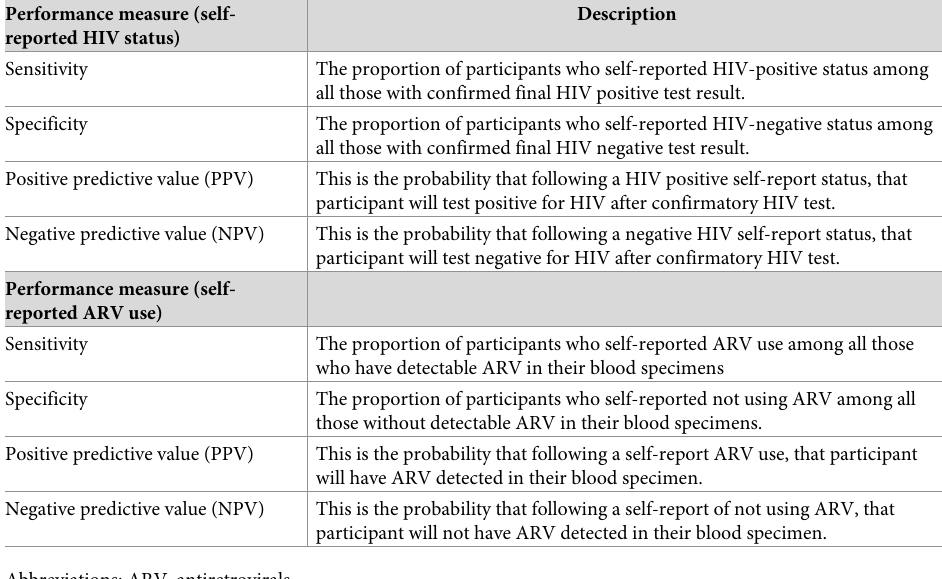
Table 1. Description of measures used in assessing performance of self-reported HIV status and self-reported ARV use (Nigeria HIV/AIDS and Indicator Survey